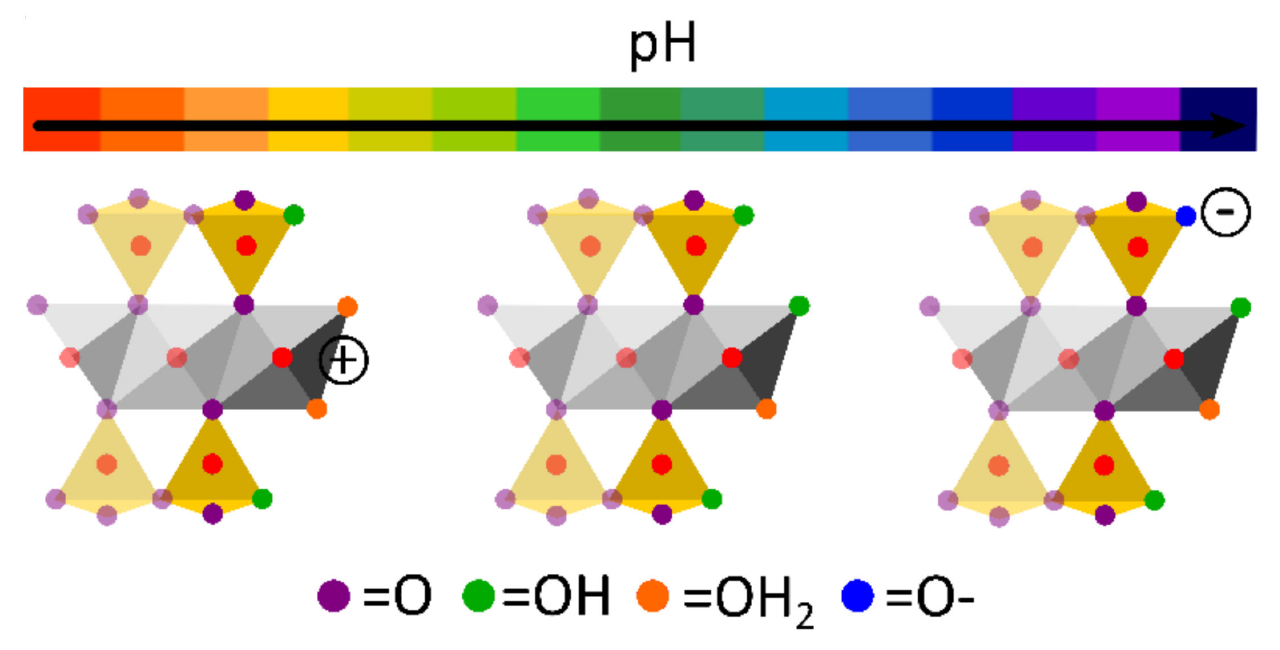
Figure 3. pH-dependent ion reactions at the edge of clay mineral